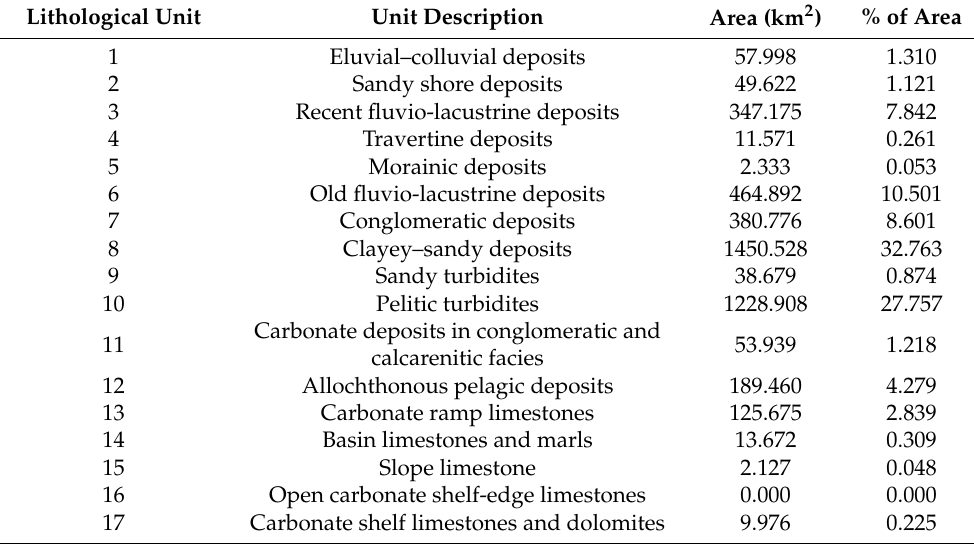
Table 1. Extension of each lithological unit in the study